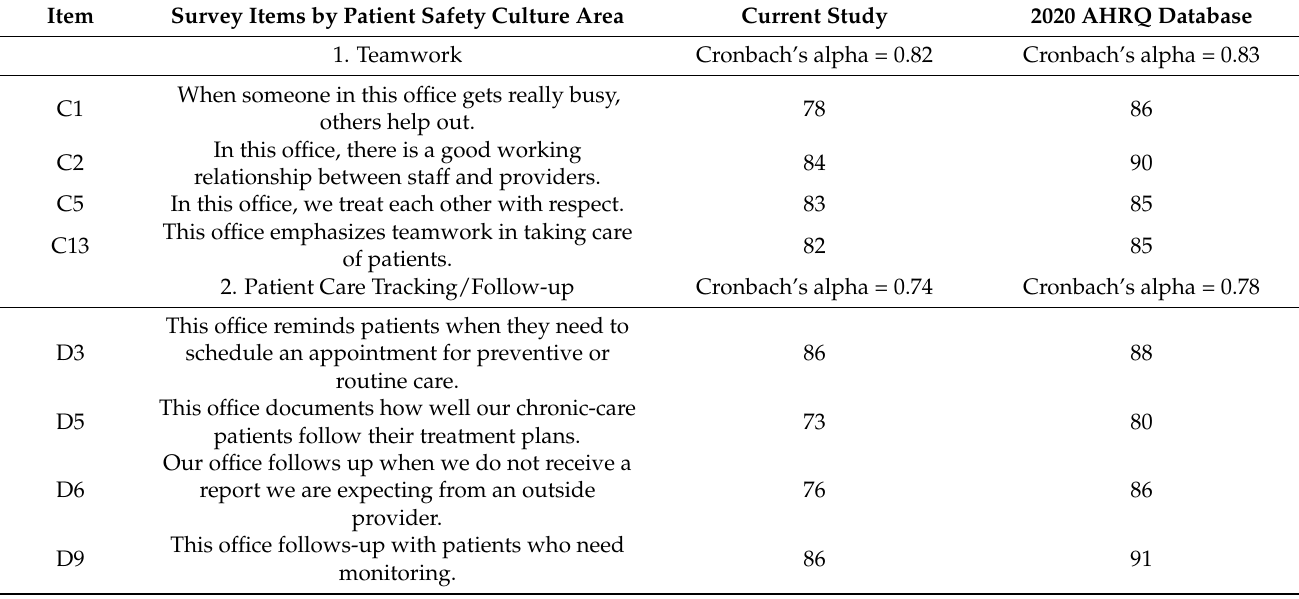
Table 3. Item-level and Cronbach’s alpha results for Greek primary care centers ( N = 78) and U.S. medical offices ( N = 1.475). Item Survey Items by Patient Safety Culture